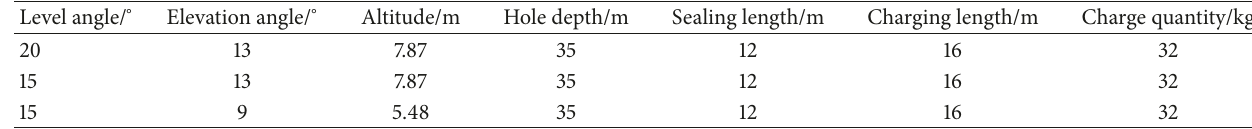
Figure 15: Damage of coal walls under the two blasting conditions. Table 5: Parameters of pressured water coupling blasting.